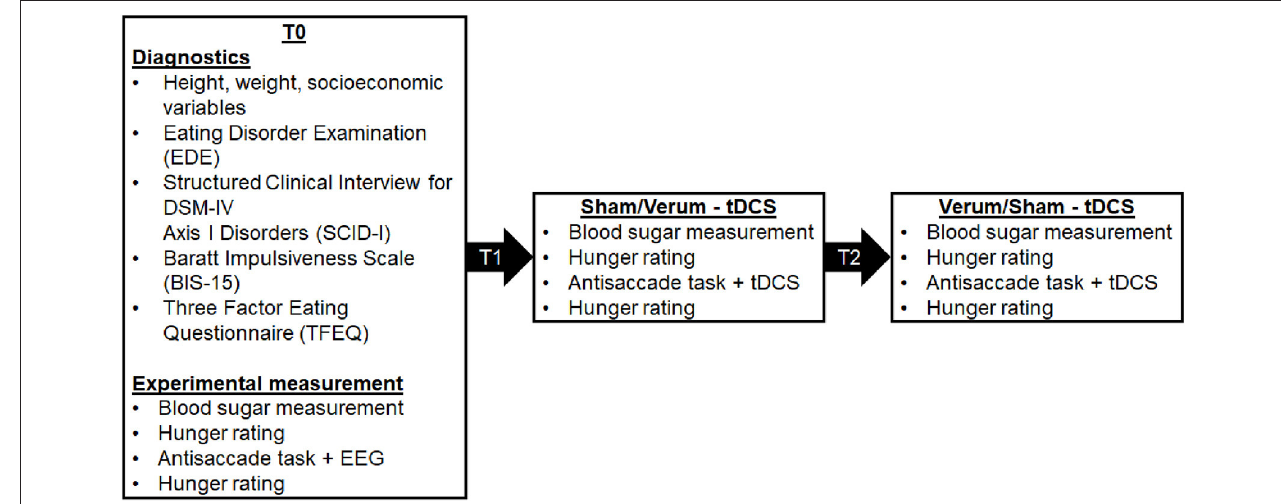
FIGURE 1 | An overview of the study appointments (T0, T1, T2) and the assessed data. The allocation to the two stimulation conditions (verum and sham stimulation) was randomised, counterbalanced and